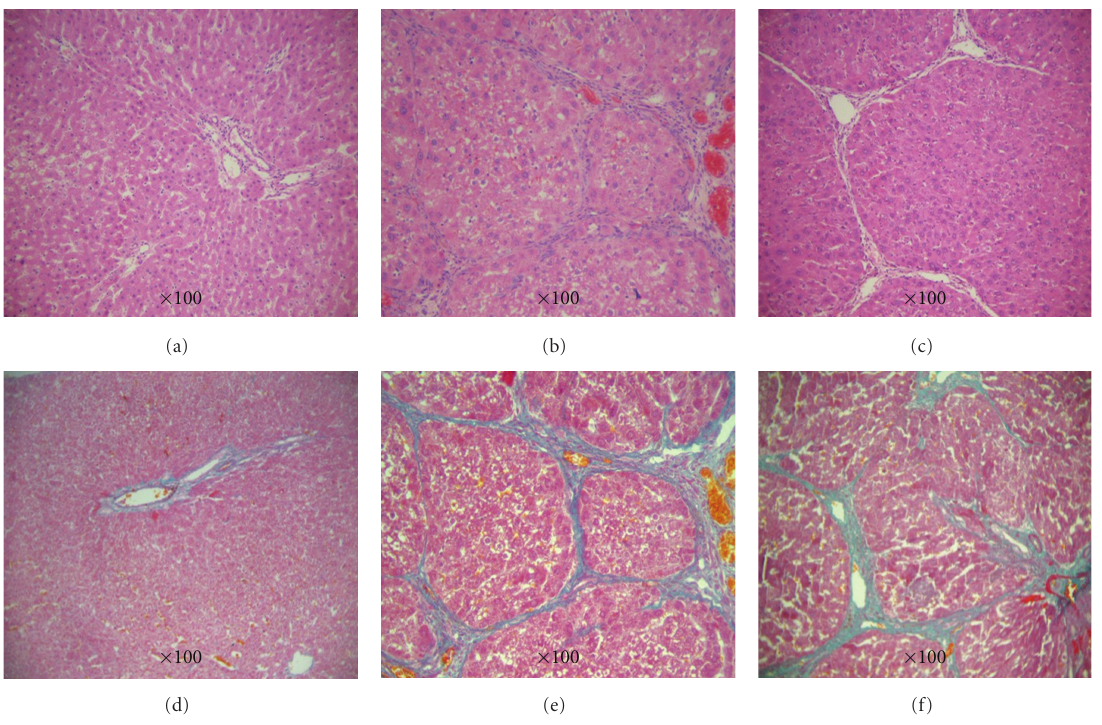
Figure 1: Progression of TAA-induced liver fibrosis in SD rats was assessed by HE and Masson-Trichrome staining at di ff erent time points of treatment. (a–c) HE staining, (a) Nomal, (b) 8w Model, and (c) 12w Model, (d–f) Masson-trichrome staining, (d) Nomal, (e) 8w Mode, and (f) 12w Mode.